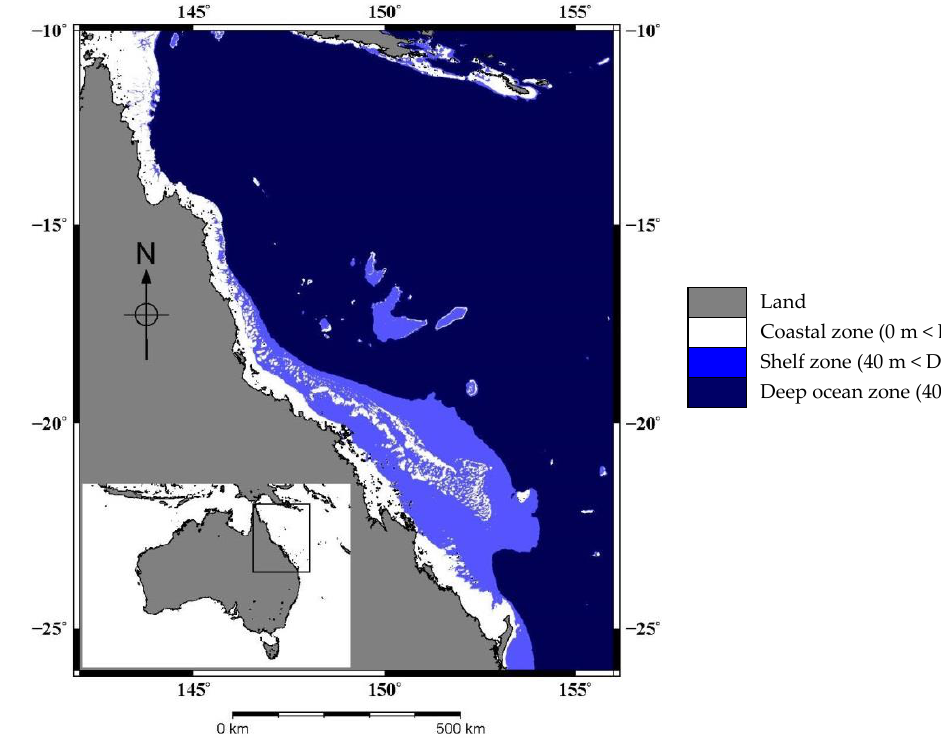
Figure 1. The bathymetry of the GBR based on the gbr100 model. It covers the deep ocean (dark shelf (steel blue) and coastal (white) blue), shelf (steel blue) and coastal (white) zones.